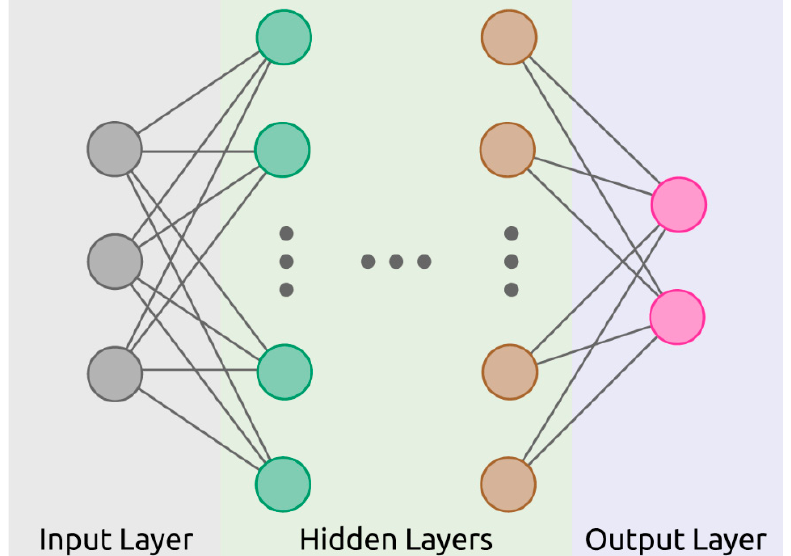
Figure 3. Artificial neural network (ANN) showing nodes of the input, hidden, and output layers.